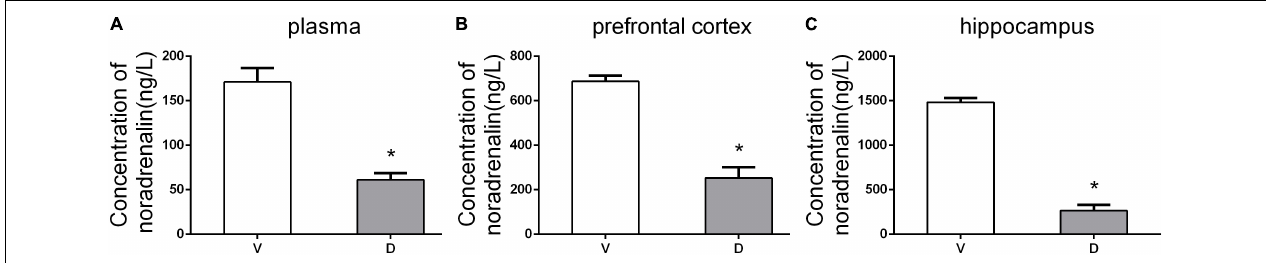
FIGURE 2 | DSP-4 treatment decreased the concentrations of noradrenaline (NE) in the plasma, prefrontal cortex, and hippocampus 7 days postoperatively. (A) NE concentrations (ng/L) in plasma. (B) NE concentrations (ng/L) in the prefrontal cortex. (C) NE concentrations (ng/L) in the hippocampus. The data are presented as the means ± SEM for each group ( n = 5 per cohort). * p < 0.05 compared to Group